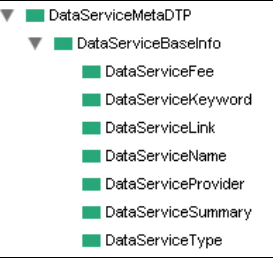
Figure 3. The hierarchical semantic properties representation of general query schema